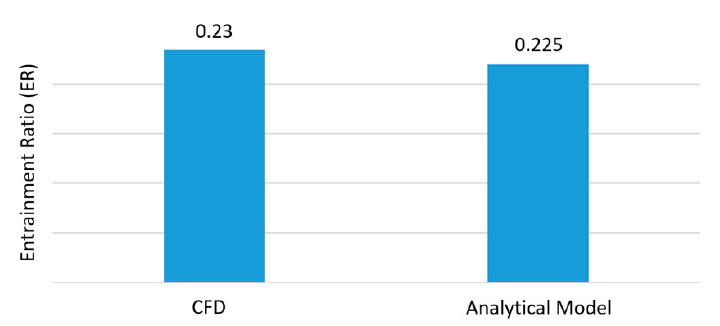
Figure 11. Validation of analytical model with CFD .